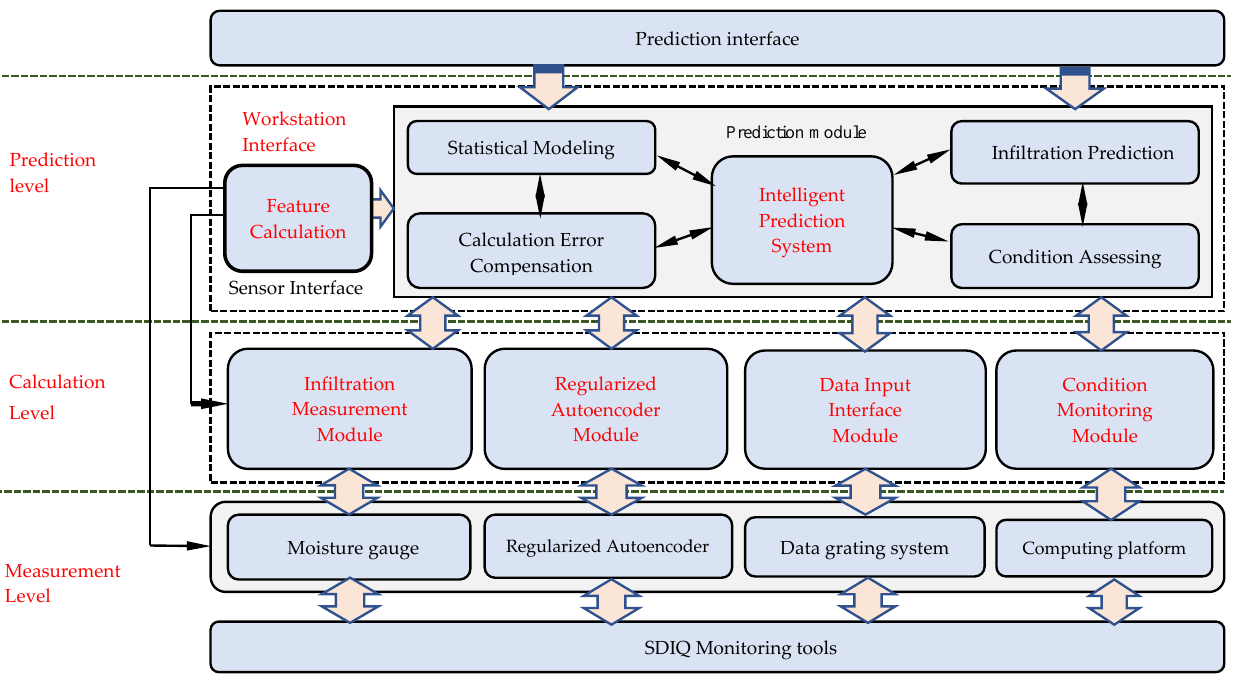
Figure 1. The operational levels and data transmission in the architecture of the RSAE.